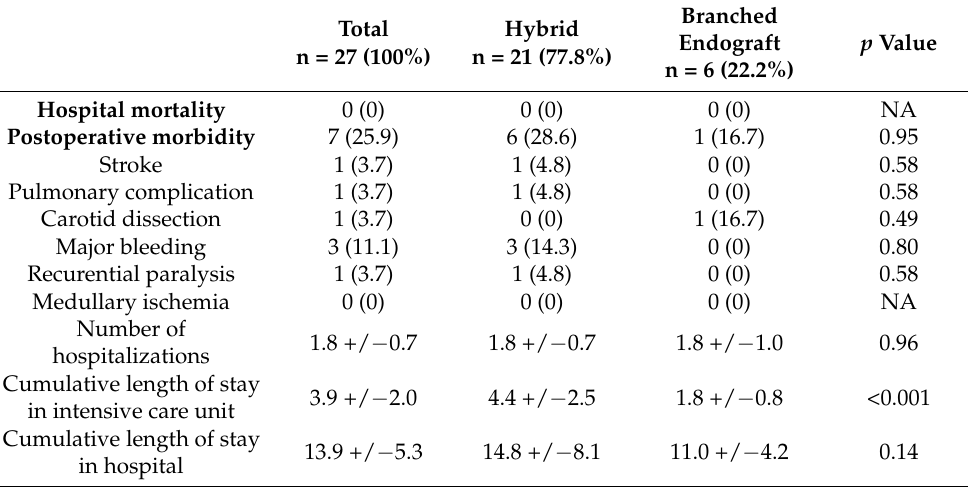
Table 3. Morbi-mortality after reintervention for distal aneurysmal evolution including aortic arch repair.